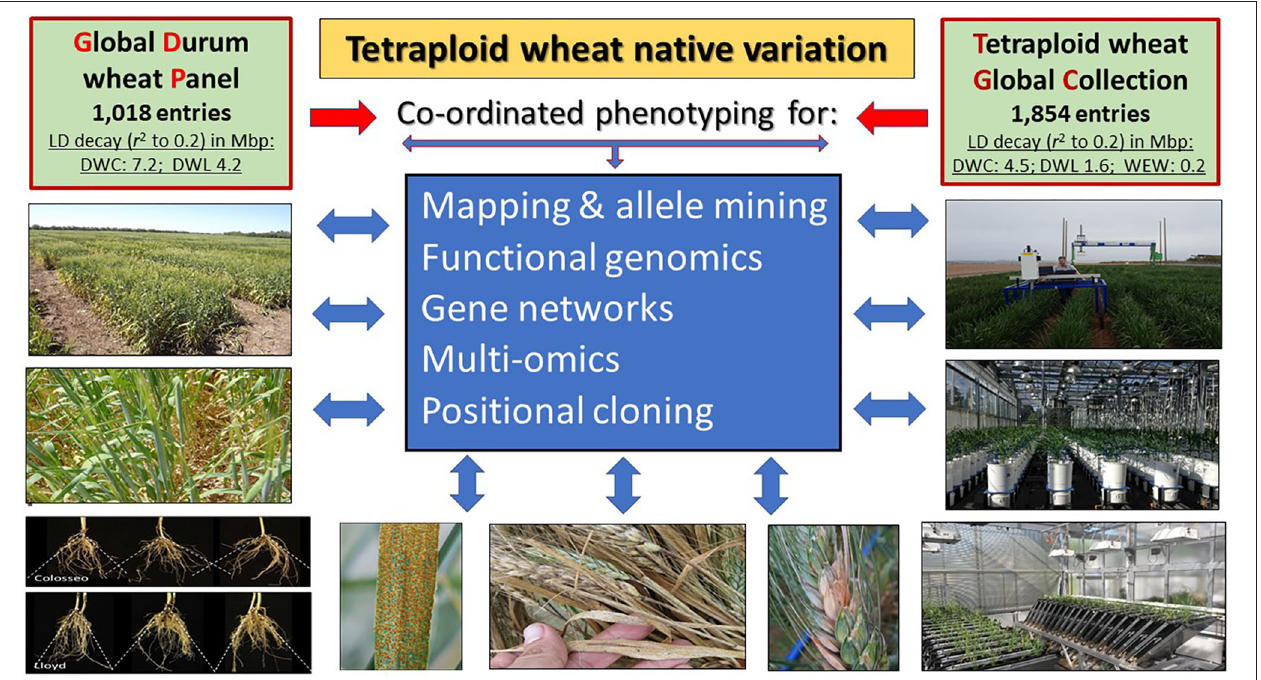
FIGURE 1 | The Global Durum wheat Panel (GDP; Mazzucotelli et al.) and the Tetraploid wheat Global Collection (TGC; Maccaferri et al., 2019) are instrumental to mine the vast biodiversity present in the A and B genomes of Triticum species. The lower linkage disequilibrium (LD) decay of the TGC suggests its suitability for cloning QTLs while the GDP is more suitable for breeding purposes. DWC, Durum Wheat Cultivars; DWL, Durum Wheat Landraces; WEW, Wild Emmer Wheat.